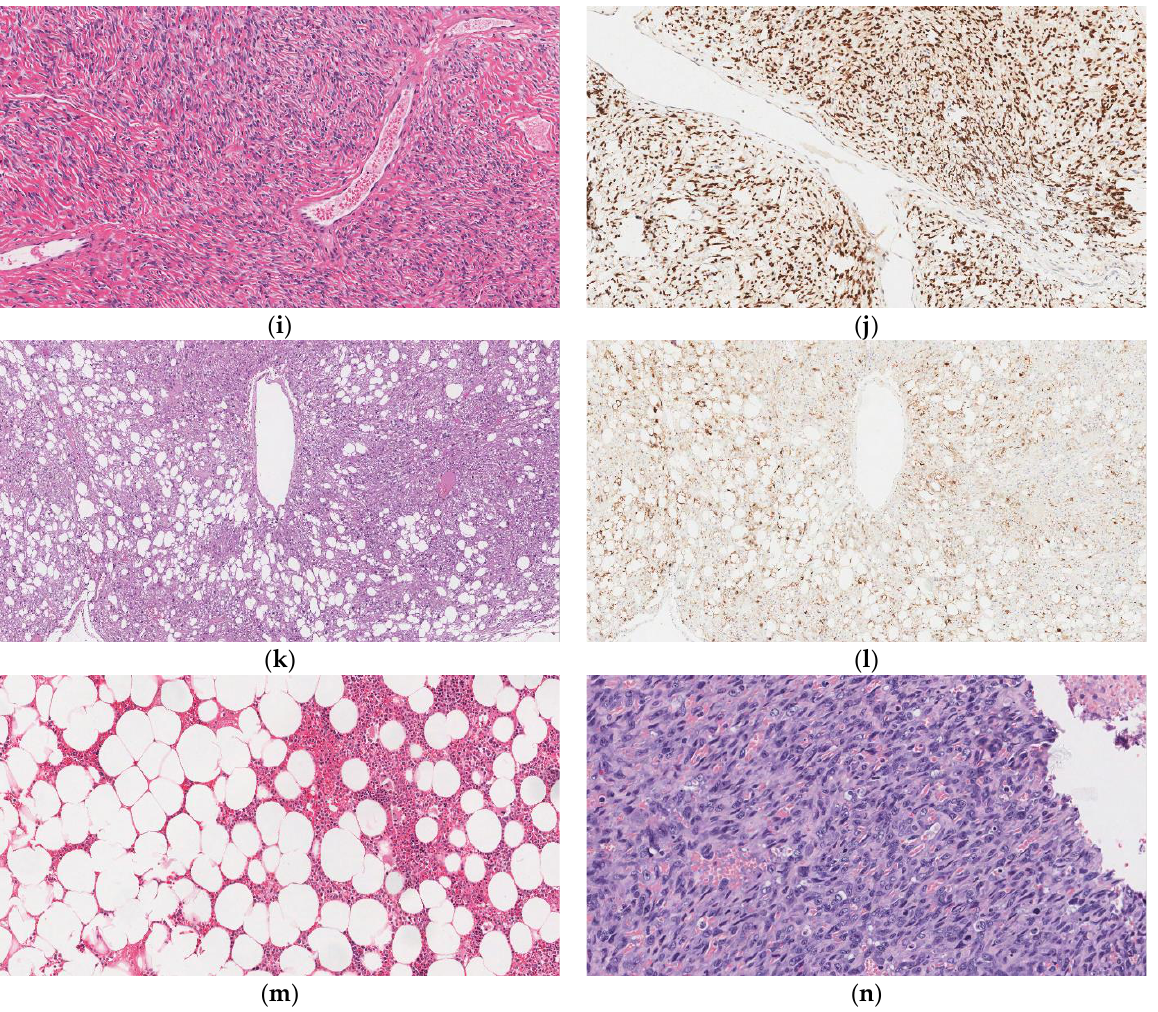
Figure 3. Photomicrographs from representative cases obtained at The Ottawa Hospital. Slides stained with Hematoxylin and Eosin (H&E) or immunohistochemistry (IHC) peroxidase as follows: Undifferentiated pleomorphic sarcoma (UPS) H&E 100× ( a ), Ewing sarcoma H&E 100× ( b ) malignant peripheral nerve sheath tumor (MPNST) with rhabdomyoblastic differentiation “Trition tumor” H&E 200× ( c ) MPNST with H3K27me3 loss IHC 200× ( d ) gastrointestinal stromal tumor (GIST) H&E 100× ( e ) inflammatory myofibroblastic tumor (IMT) H&E 100× ( f ) conventional chordoma H&E 100× ( g ) conventional chordoma with brachyury expression IHC 100× ( h ) solitary fibrous tumor (SFT) H&E 100× ( i ) SFT with STAT6 expression IHC 100× ( j ) Angiomyolipoma (AML) H&E 40× ( k ) AML with HMB45 expression IHC 40× ( l ) myelolipoma H&E 100× ( m ) angiosarcoma H&E 200× ( n ).